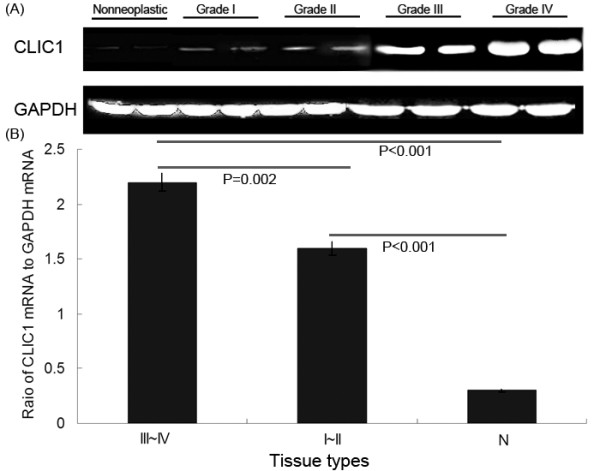
CLIC1 mRNA expression in 20 glioma tissues with different grades and in non-neoplastic brain tissues were detected by real-time quantitative RT-PCR assay. (A) Expression levels of CLIC1 mRNA in glioma tissues with different grades and non-neoplastic brain tissues. (B) A graphical representation of the CLIC1 mRNA level expression profiles in (A). ‘N’ refers to non-neoplastic brain tissues; ‘I~II’ refers to glioma tissues with grade I~II; ‘III~IV’ refers to glioma tissues with grade III~IV.